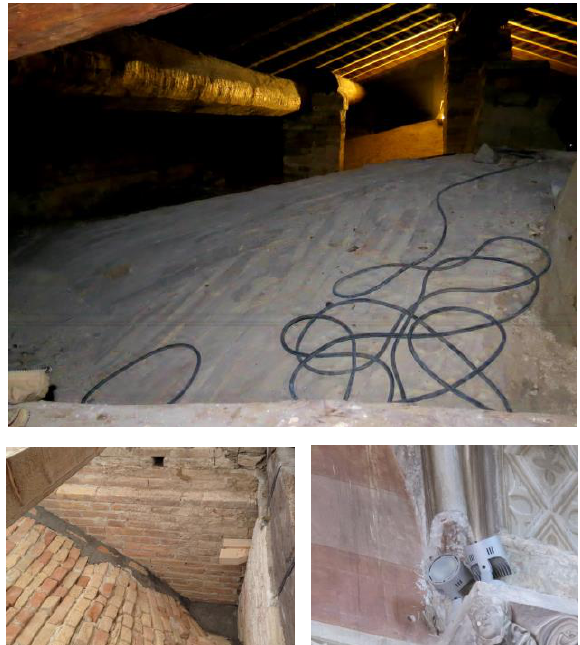
Figure 5. Construction details in masonry vaults in the church of St. Bassiano: a, b) masonry texture in the web, c) detail of the rib after a local inspection